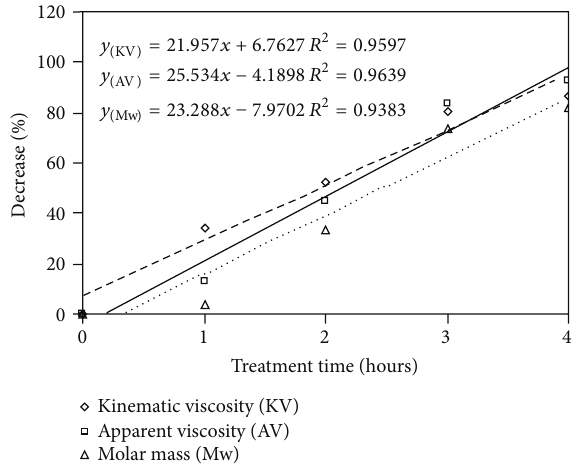
Figure 3: Decrease in kinematic and apparent viscosities and molar masses of chitosans in solid state thermally degraded at 100 ∘ C for 4h ( 𝑃 ≤ 0.05